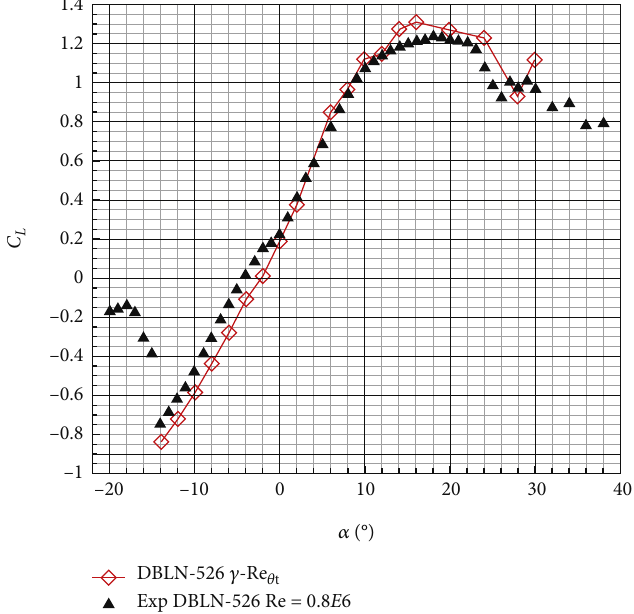
Figure 10: Lift coe ffi cient of DBLN-526 airfoil ( Re = 0 : 8 E 6